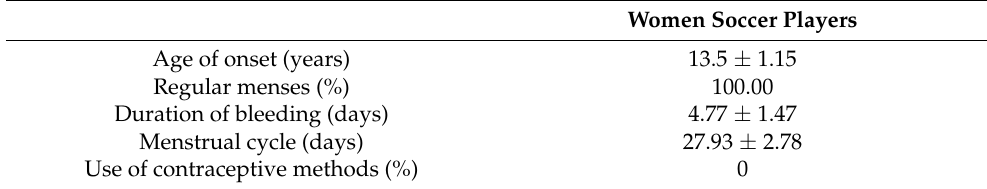
Table 2. Characteristics of the menstrual cycle of the women soccer